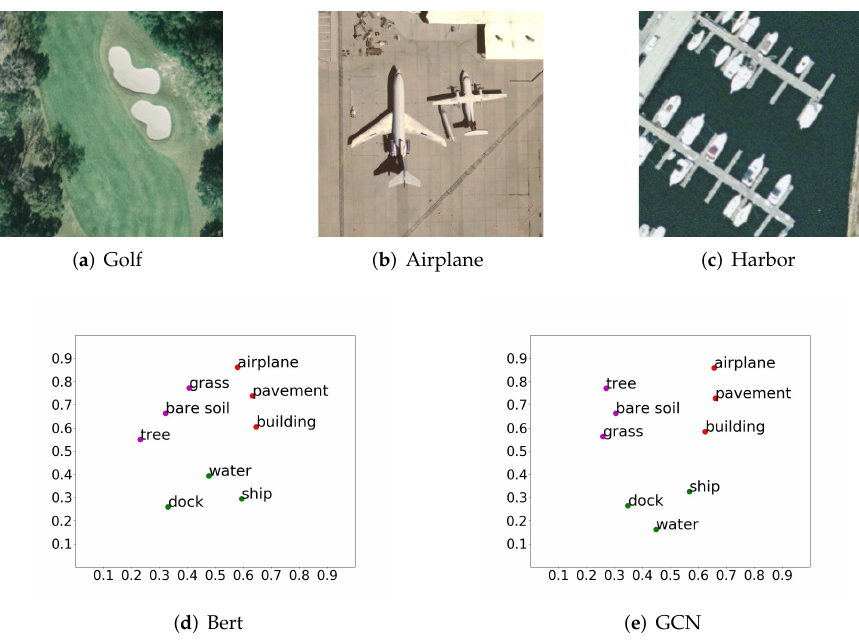
Figure 8. t-SNE visualization of label vectors in three pictures by different representation